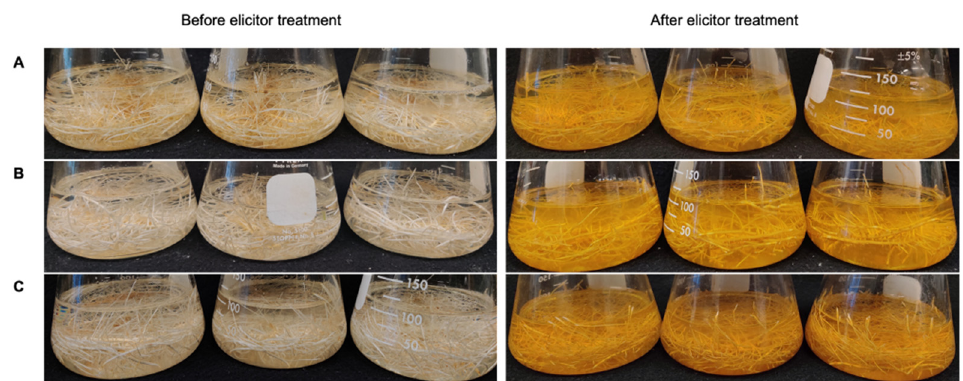
Figure 3. Elicitation of hairy root cultures. Changes in the phenotype of ( A ): Peanut cv. Tifrunner hairy root line 1; ( B ): Peanut cv. Hull line 3; ( C ): Peanut cv. Georgia Green after 168 h of treatment with different elicitors: 125 µM methyl jasmonate (MeJA), 18 g/L cyclodextrin (CD), 3 mM hydrogen